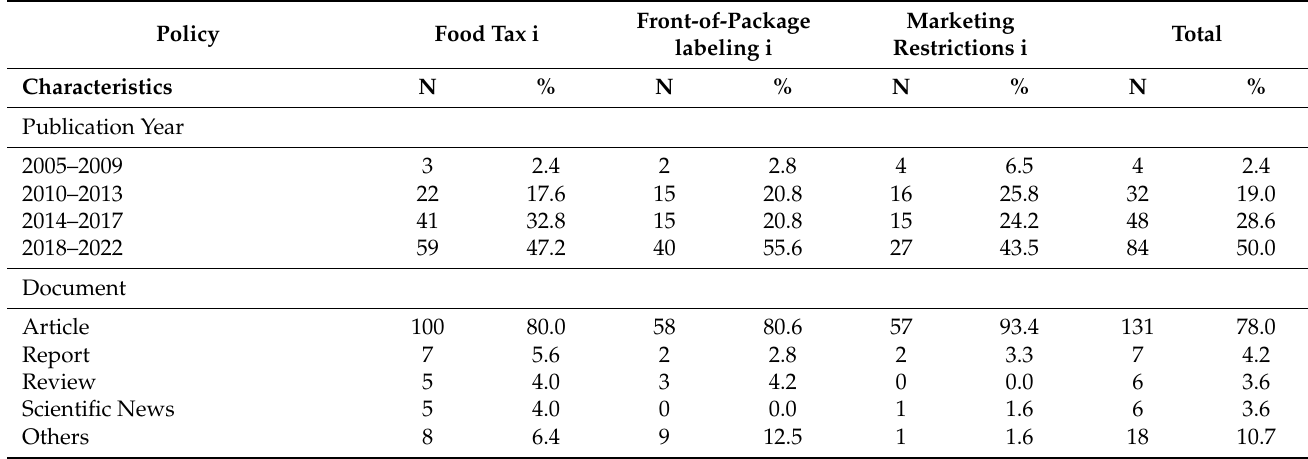
Table 2. Number and percentage of documents characteristics by food policy.